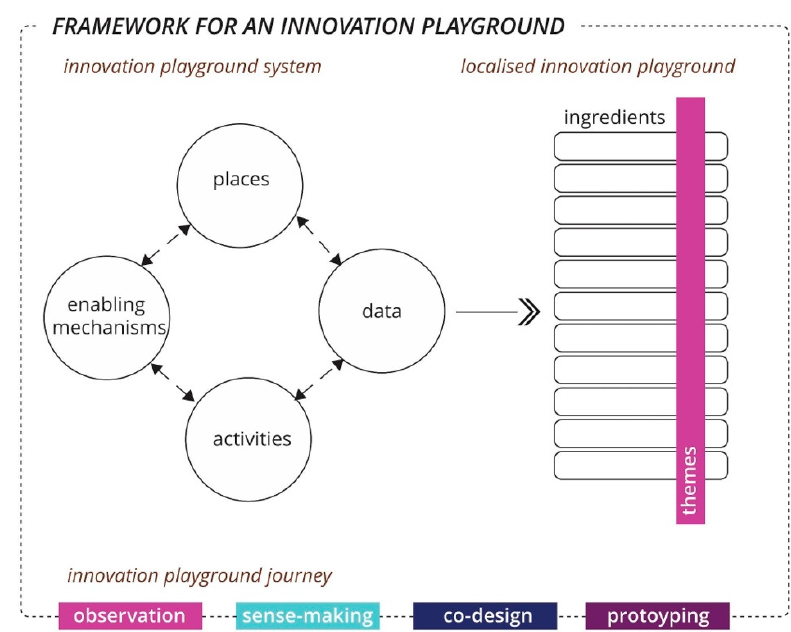
Figure 3. Innovation Playground Framework definition image (Source: [5]).